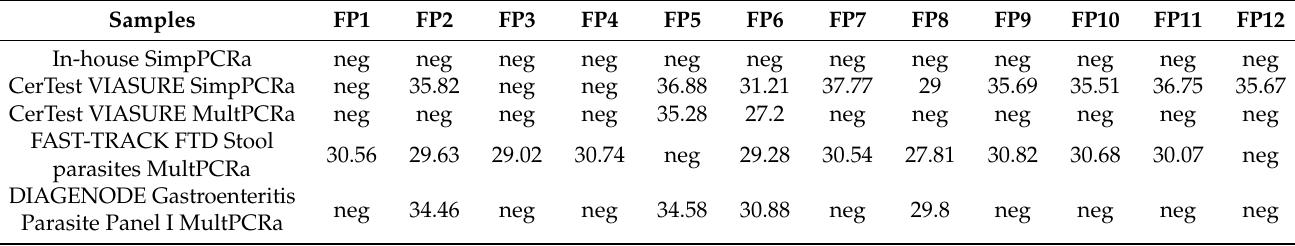
Table 6. Cycle thresholds of the twelve positive samples for G. intestinalis with at least one of the commercial PCR assays but negative with the in-house SimPCRa (i.e., false positive samples). Samples In-house SimpPCRa CerTest VIASURE SimpPCRa